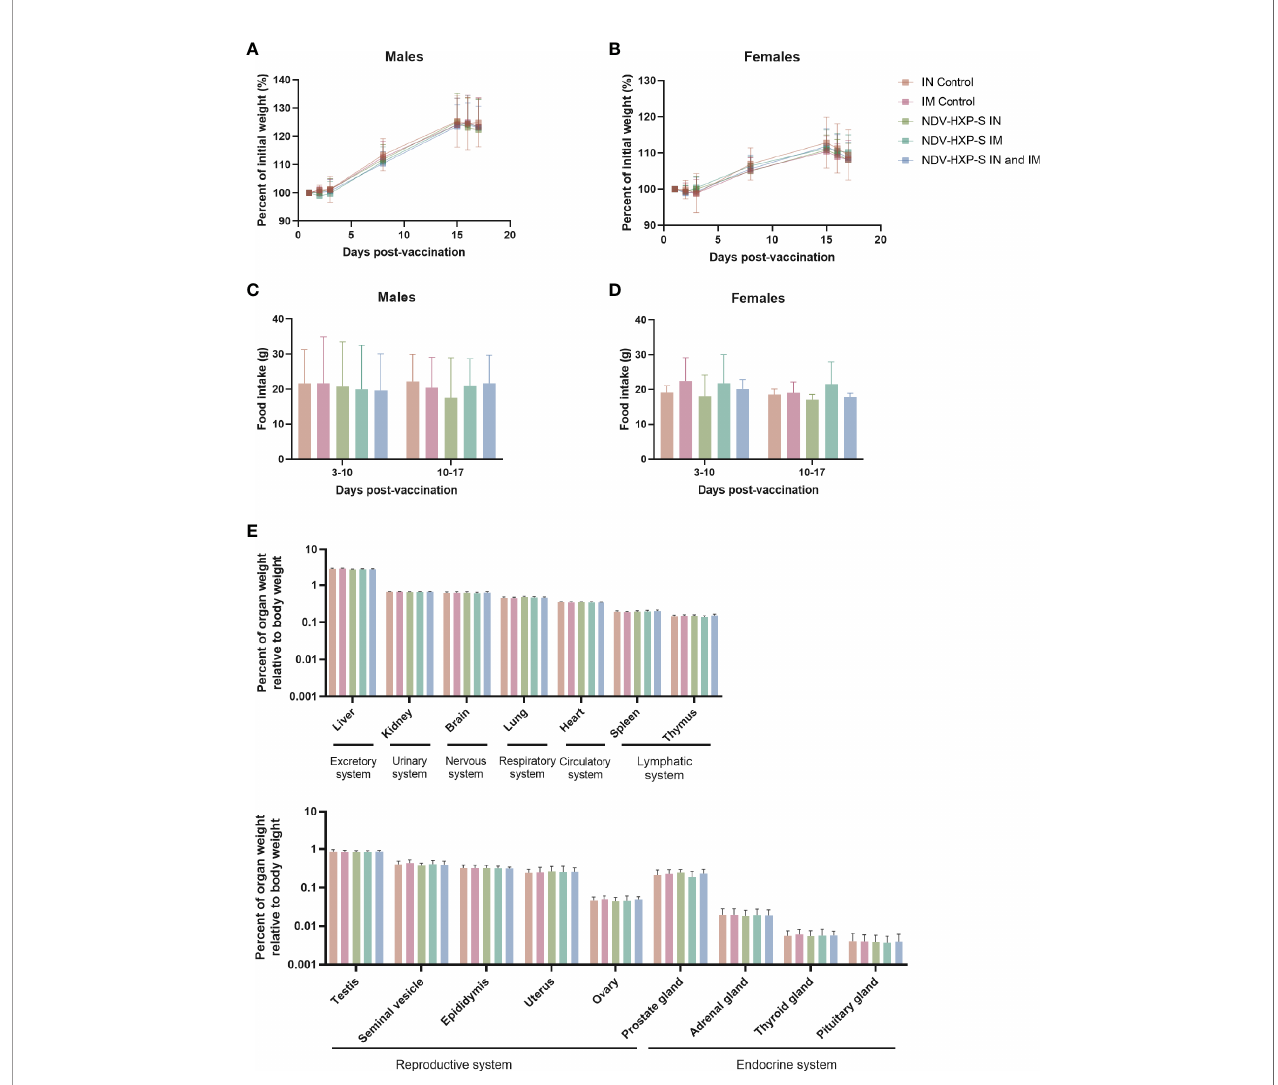
FIGURE 3 | Clinical and post-mortem evaluations in vaccinated rats. The percentage of initial weight following vaccination of male (A) or female (B) rats is shown. Weight measurements were performed on days 1, 2, 3, 8, 15, 16, and 17 after vaccination. Food consumption was measured daily and averaged over two different periods: 3-10 or 10-17 days after vaccination. The average food intake in males (C) and females (D) is shown. Weight of organs corresponding to excretory, urinary, nervous, respiratory, circulatory, lymphatic, reproductive and endocrine systems are shown (E) . Geometric mean with geometric standard deviation (SD) for the IN control, IM control, IN vaccinated, IM vaccinated, and IN-IM vaccinated groups is shown in (A – E) . No signi fi cant differences between the vaccinated groups and their respective controls were